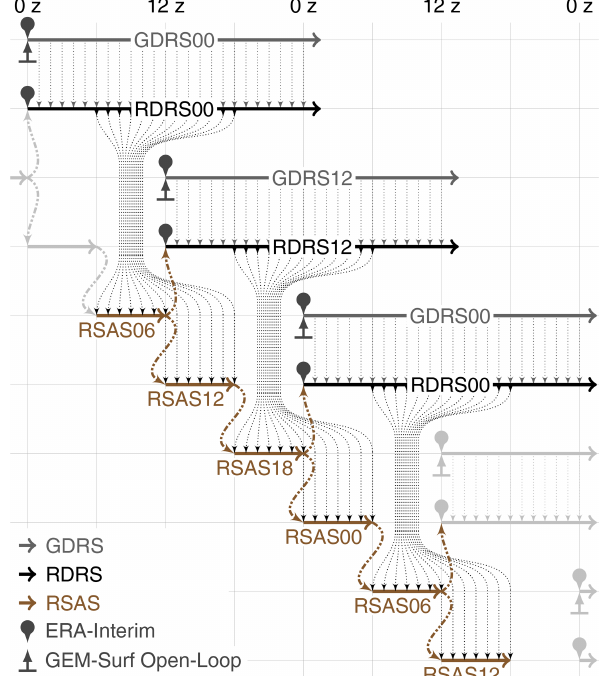
Figure 2. Flowchart of the method followed to produce a land- surface and precipitation